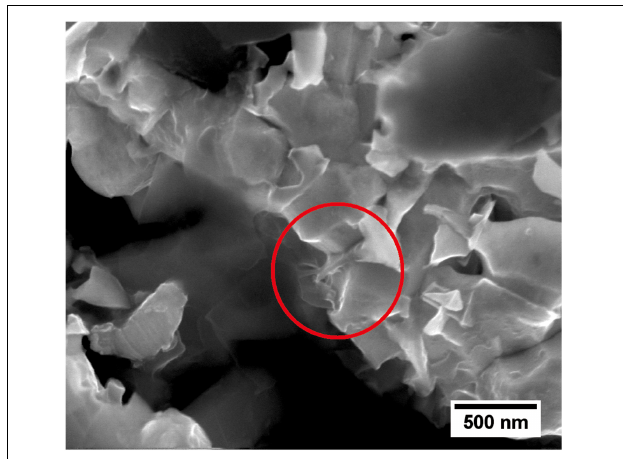
FIGURE 6 | Elongated Si 3 N 4 grain pinned by UPBNNF in WC matrix.